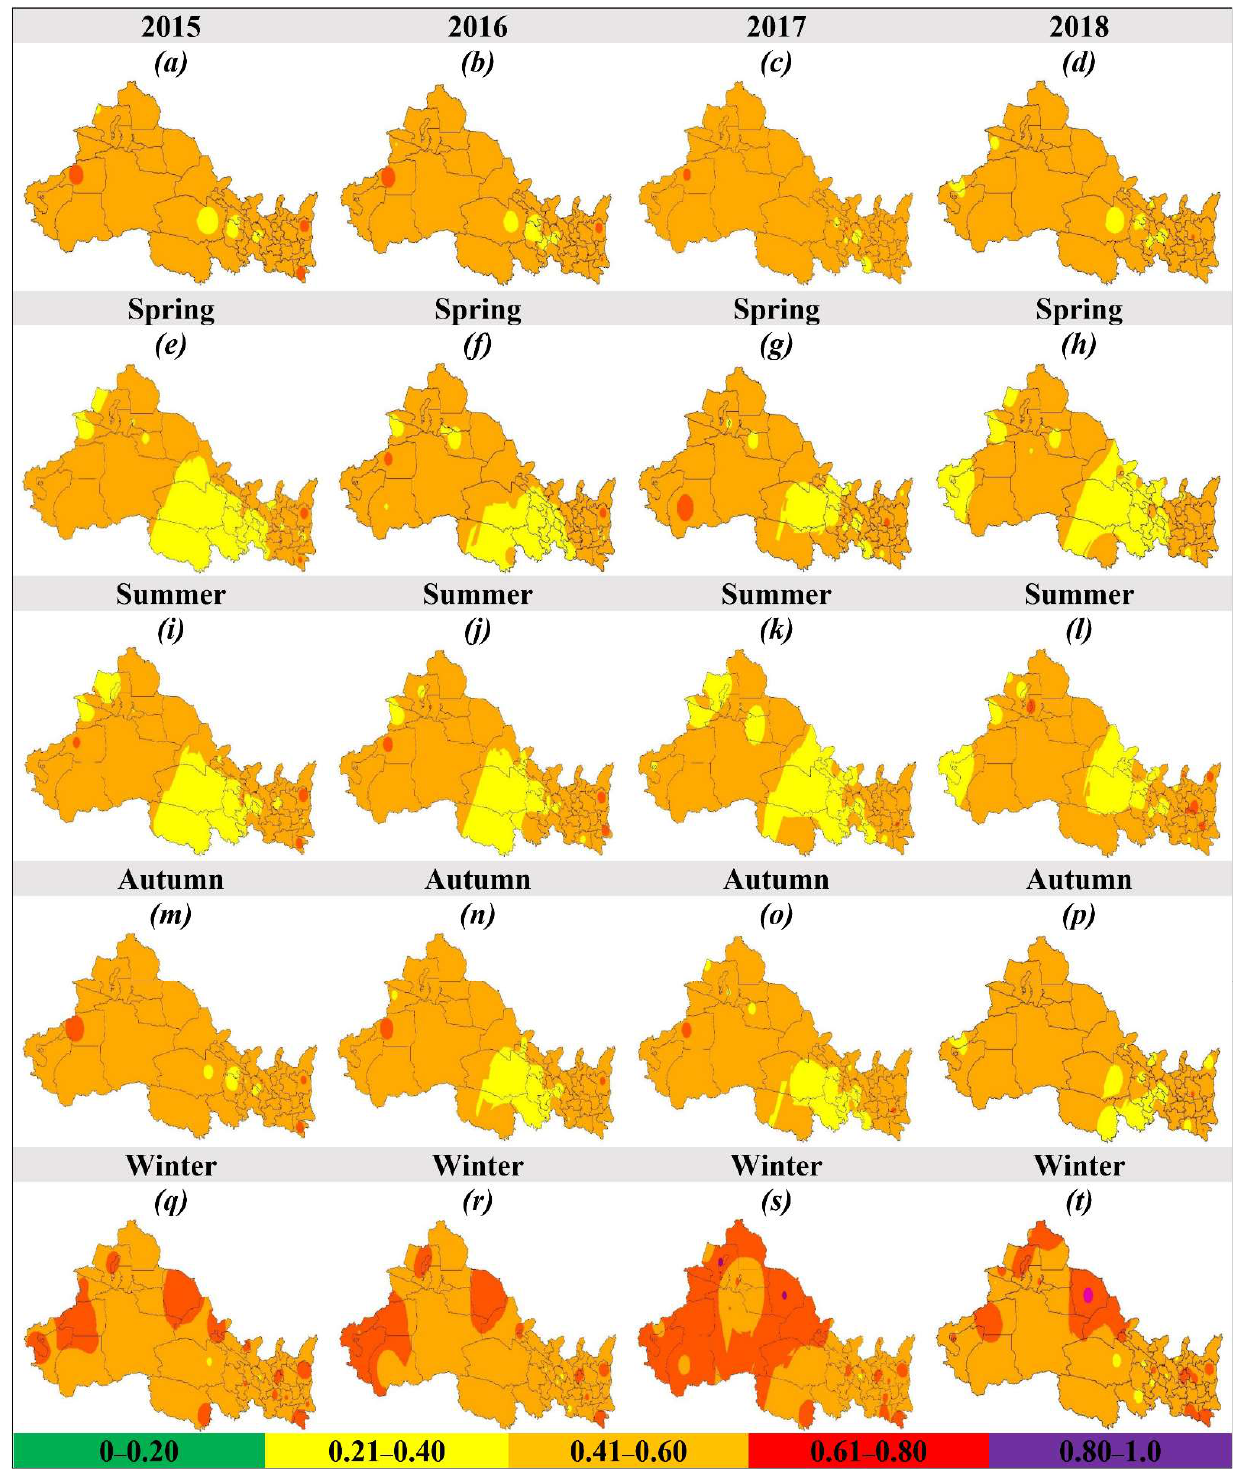
Figure 5. Annual ( a – d ) and seasonal (spring ( e – h ), summer ( i – l ), autumn ( m – p ), and winter ( q – t )) spatial distribution of PM 2.5 /PM 10 in 53 cities of northwest China (NWC) between 2015 and 2018. Color represents the different pollution levels, e.g., green (good), yellow (moderate), orange (unhealthy for a sensitive group), red (unhealthy for all), purple (very unhealthy), and maroon (haz- ardous).